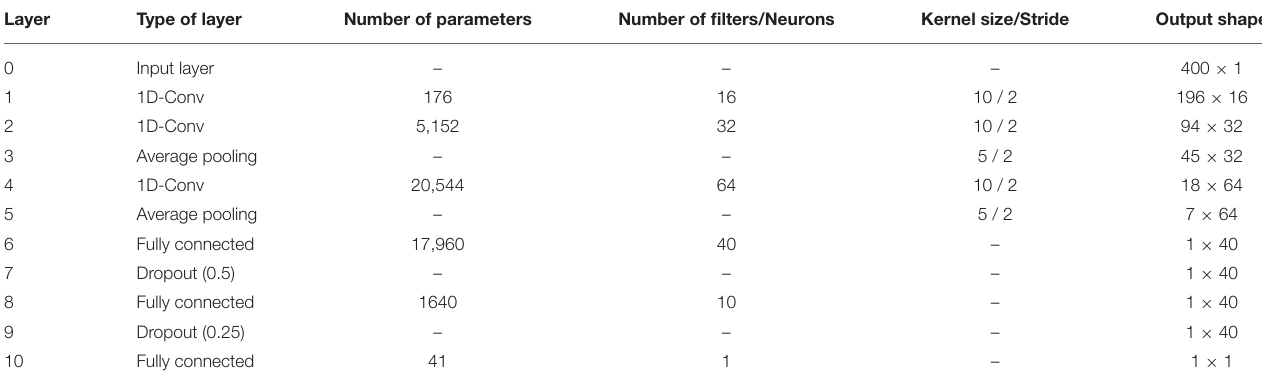
TABLE 3 | Definition of layers and parameters of the proposed CNN.